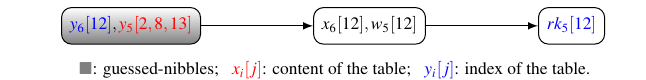
Figure 7: Construction of Table T 1 on the 10-round attack. There are about 2 8 values for each index in average.